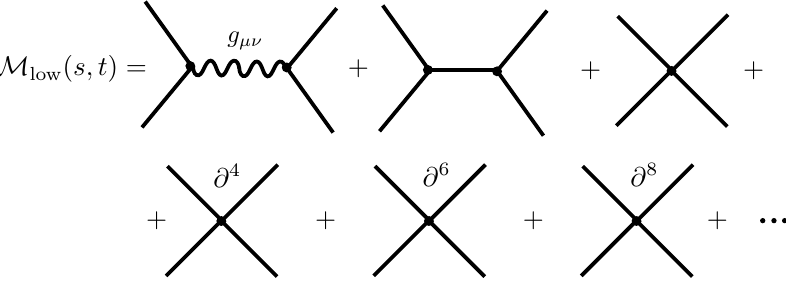
Figure 1 . A schematic representation of the low-energy amplitude (2.1). The external scalar particles interact through graviton exchange, scalar exchange and a series of higher-derivative con- tact